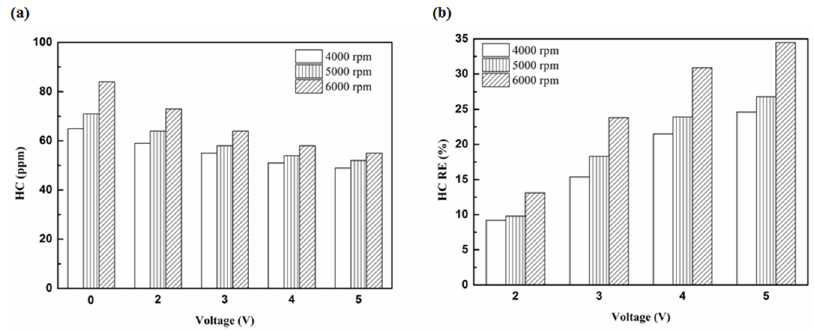
Figure 7. The HC ( a ) emission values and ( b ) RE using platinum in the rear of the exhaust pipe.